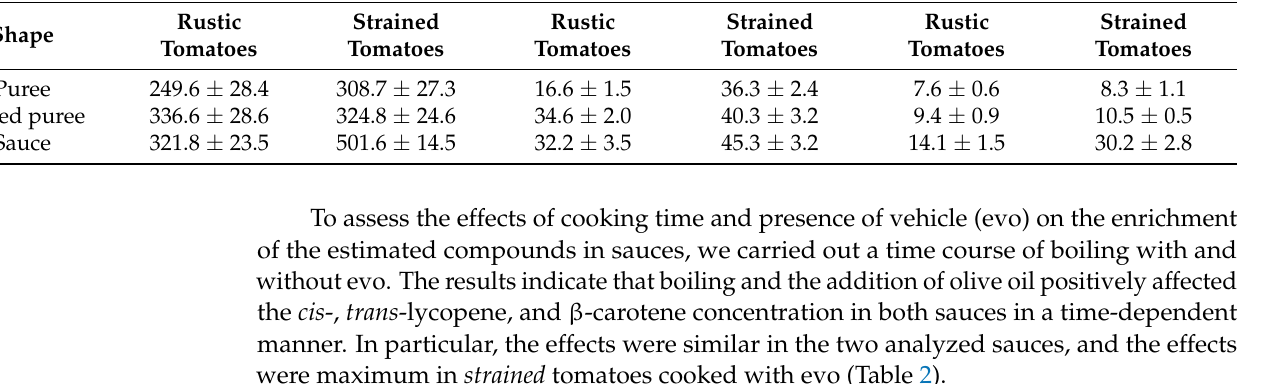
Table 1. 5- cis - and trans -lycopene isoforms and β -carotene content in tomato samples. “Puree” is uncooked tomato puree; “Boiled puree” is tomato puree boiled in a beaker for 10 min at 100 ◦ C without evo; “Sauce” is tomato puree prepared with the addition of olive oil (50 g/L) and boiled for 20 min. Values represent the mean of three different measures ± SD. Fixed residue at 105 ◦ C was 21.8% in rustic tomato pur è e and 20.8% in the strained one.